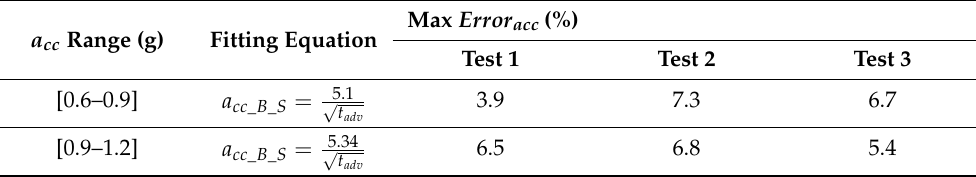
Table 1. Experimental results with maximum error in measurement for two different acceleration